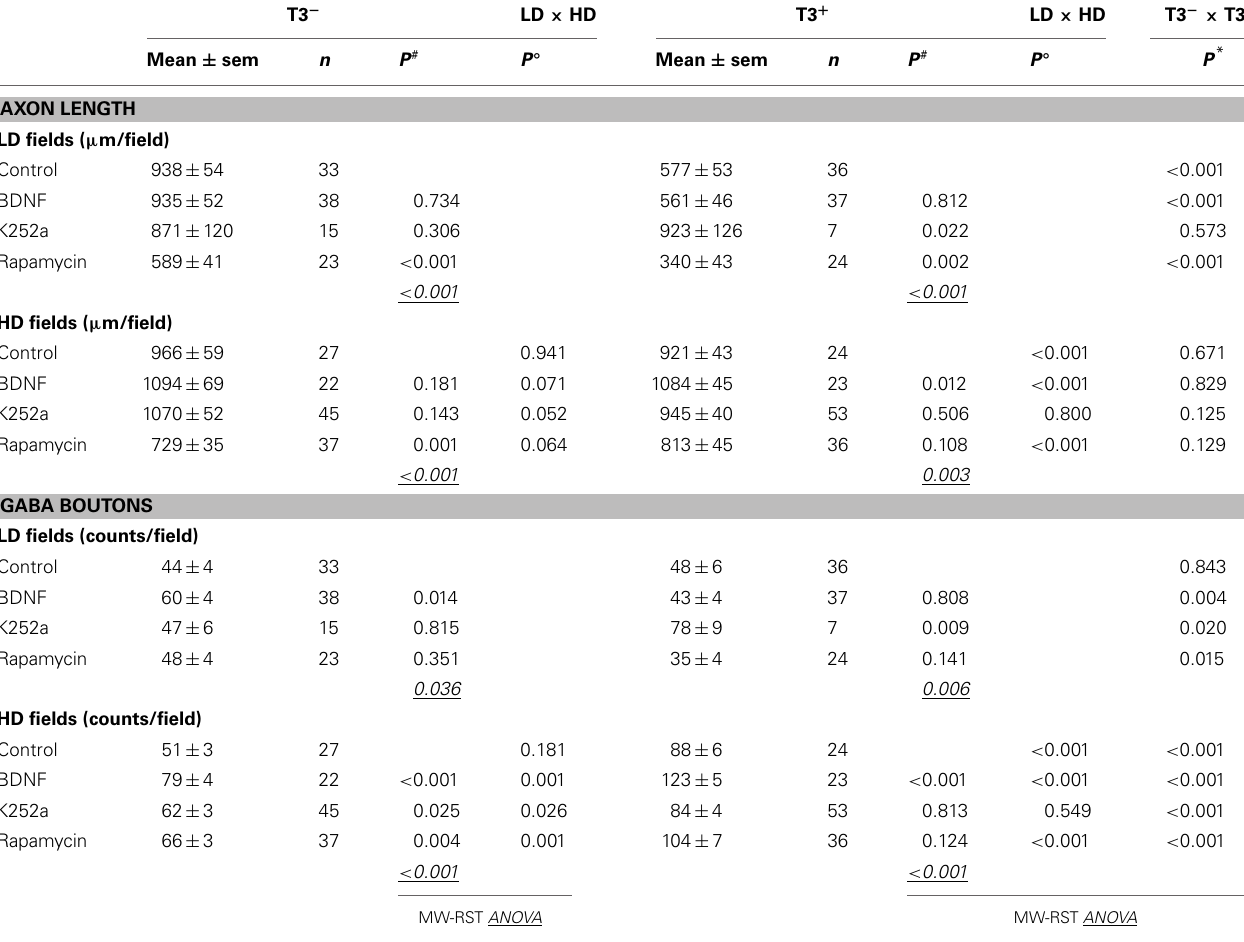
Table 6 | Summary of the axonal parameters considering circuitry